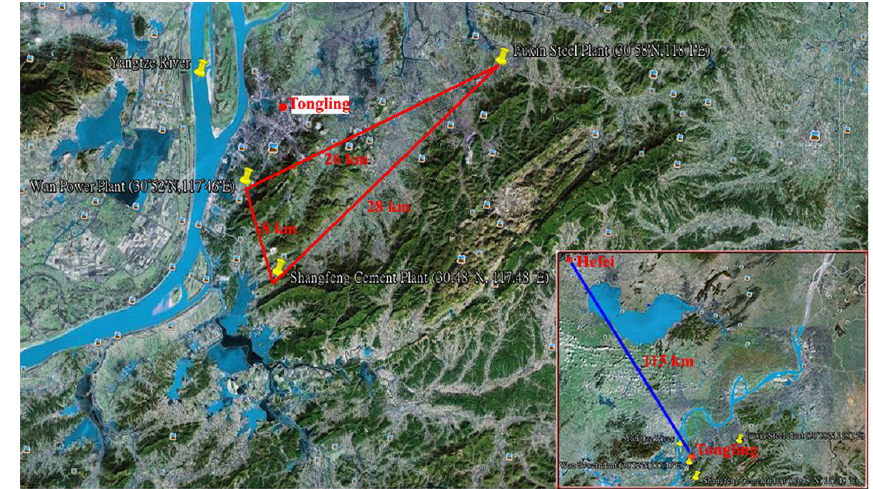
Figure 11. The location of the Fuxin steel plant (30.58 ◦ N, 118.1 ◦ E), the Wan power plant (30.52 ◦ N, 117.46 ◦ E), and the Shangfeng cement plant (30.48 ◦ N, 117.48 ◦ E). The three factories form a triangle near the Yangtze River, and all are located in the suburbs of the city of Tongling (south of Hefei, Anhui province) in central China.